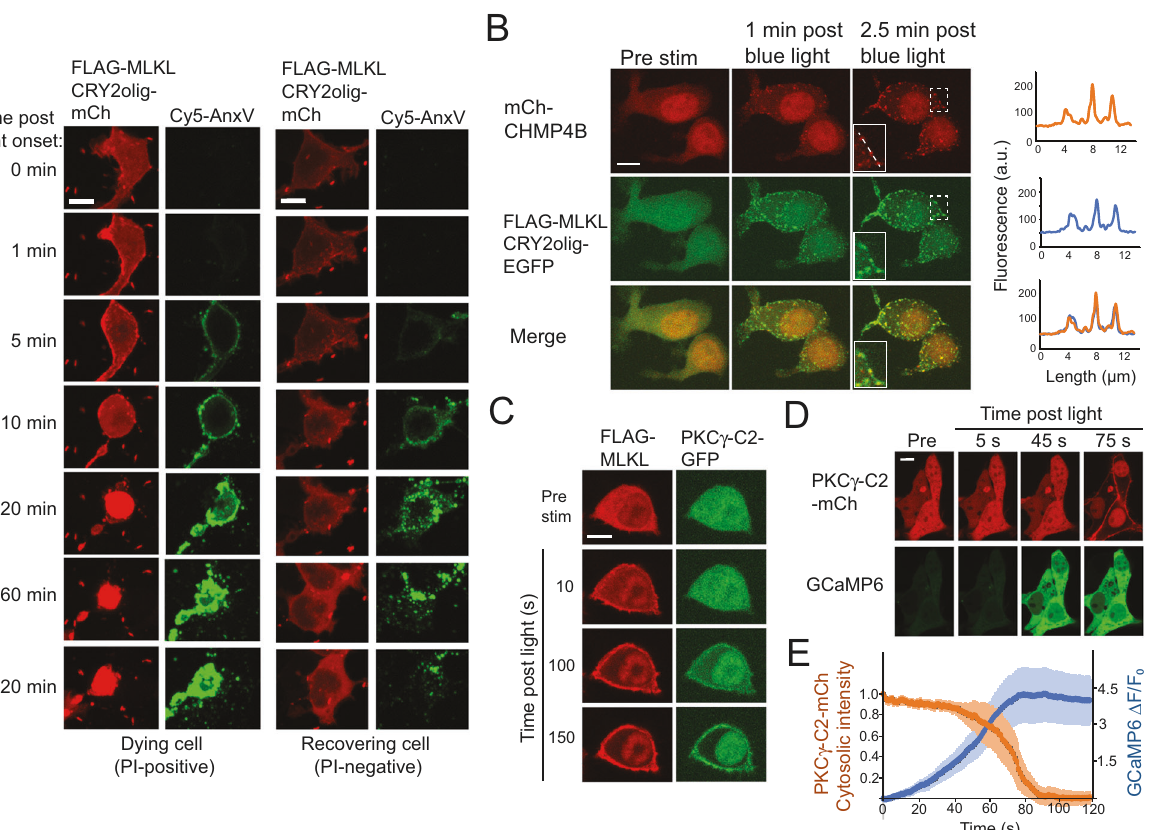
Fig. 3 Cellular response to light-stimulated MLKL damage. A Representative images of HEK293T cells expressing FLAG-MLKL-CRY2olig-mCh and exposed to blue light showing staining with Cy5-Annexin V and 1 µg/ml PI. Cells were exposed to a mild light stimulus (single, 150 ms pulse of 488 nm light) and tracked for 120 min. The majority of cells that showed Annexin V after light treatment ultimately underwent cell death, represented by PI staining in the mCherry channel (the two left panels show an example of these cells). Approximately 9% of cells that showed Annexin V staining after light treatment did not show PI staining and recovered (right panel). Scale bars, 10 µm. B Representative HEK293T cells showing colocalization of FLAG-MLKL-CRY2olig-EGFP and mCherry-CHMP4B on the PM after light stimulation. The graph at right shows the quanti fi cation of fl uorescence intensity along the dotted white line. Scale bar, 10 µm. C Representative images of cells expressing FLAG-MLKL-CRY2olig-mCh and PKC γ -C2-GFP. PKC γ -C2-GFP is recruited to the PM within 100 s after light-triggered MLKL stimulation. Scale bar, 10 µm. D , E Dual visualization of Ca 2 + and PKC-C2 γ responses following FLAG-MLKL stimulation. Representative images ( D ) and quanti fi cation ( E ) of cells expressing FLAG-MLKL-CRY2olig-miRFP and the sensors PKC γ -C2-mCh and GCaMP6 before and after blue light stimulation (100 ms pulse of 488 nm light). The orange graph shows the change in normalized cytosolic fl uorescence intensity of mCherry signal over time in cells expressing PKC γ -C2-mCh. The blue graph shows GCaMP6 signal ( Δ F / F 0 ) change over time. An increase in intracellular Ca 2 + is observed ~40 s after light application, followed by recruitment of C2 γ -mCh to the PM. Quanti fi cation is from n = 5 cells from two independent experiments. Scale bar, 10